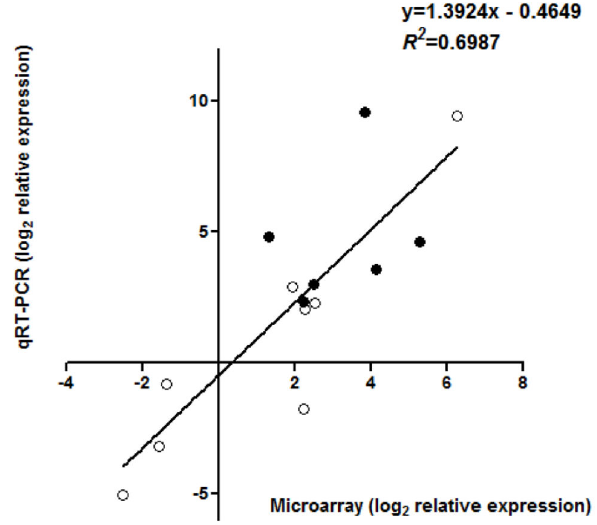
Figure 5. Comparison of microarray and quantitative real- time PCR data for selected genes. Symbols represent mean expression levels in bacterial-infiltrated relative to mock- inoculated leaflets of Gifu B-129 (●) or MG-20